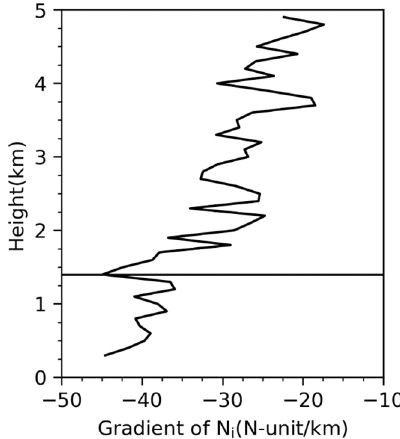
− (12) where N ss (r), N ssdry (r), and N sswet (r) are the spherically symmetric refractivity, dry refractiv- ity, and wet refractivity. The individual refractivity profile is only a function of r . Equa- tions (10)–(12) refer to the individual profile only. Figure 3 depicts the profiles of the spherically symmetric refractivity and the vertical gradient of the spherically symmetric refractivity on 2 January 2008. They hardly changed over time. Figure 3. ( a ) The spherically symmetric refractivity and ( b ) vertical gradient profiles on 2 January